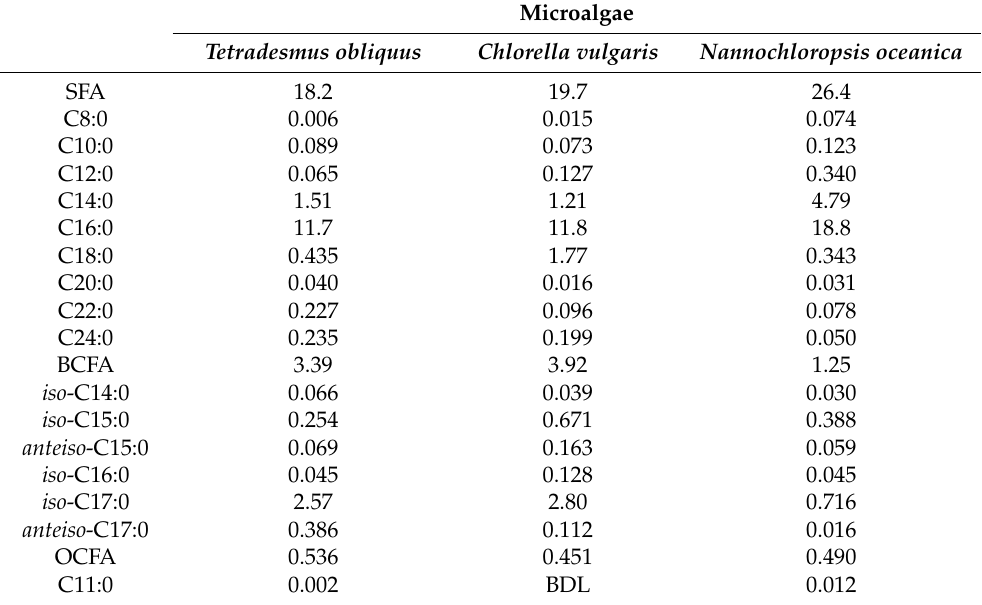
Table 4. Fatty acid content of the studied microalgae species (g kg − 1 dry matter) 1